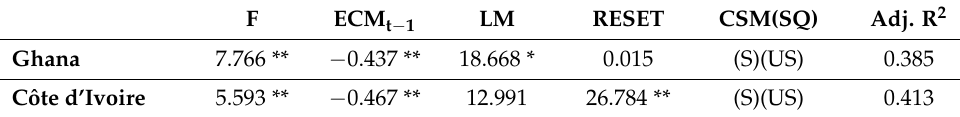
Table 4. Diagnostic Tests Associated with Nonlinear ARDL